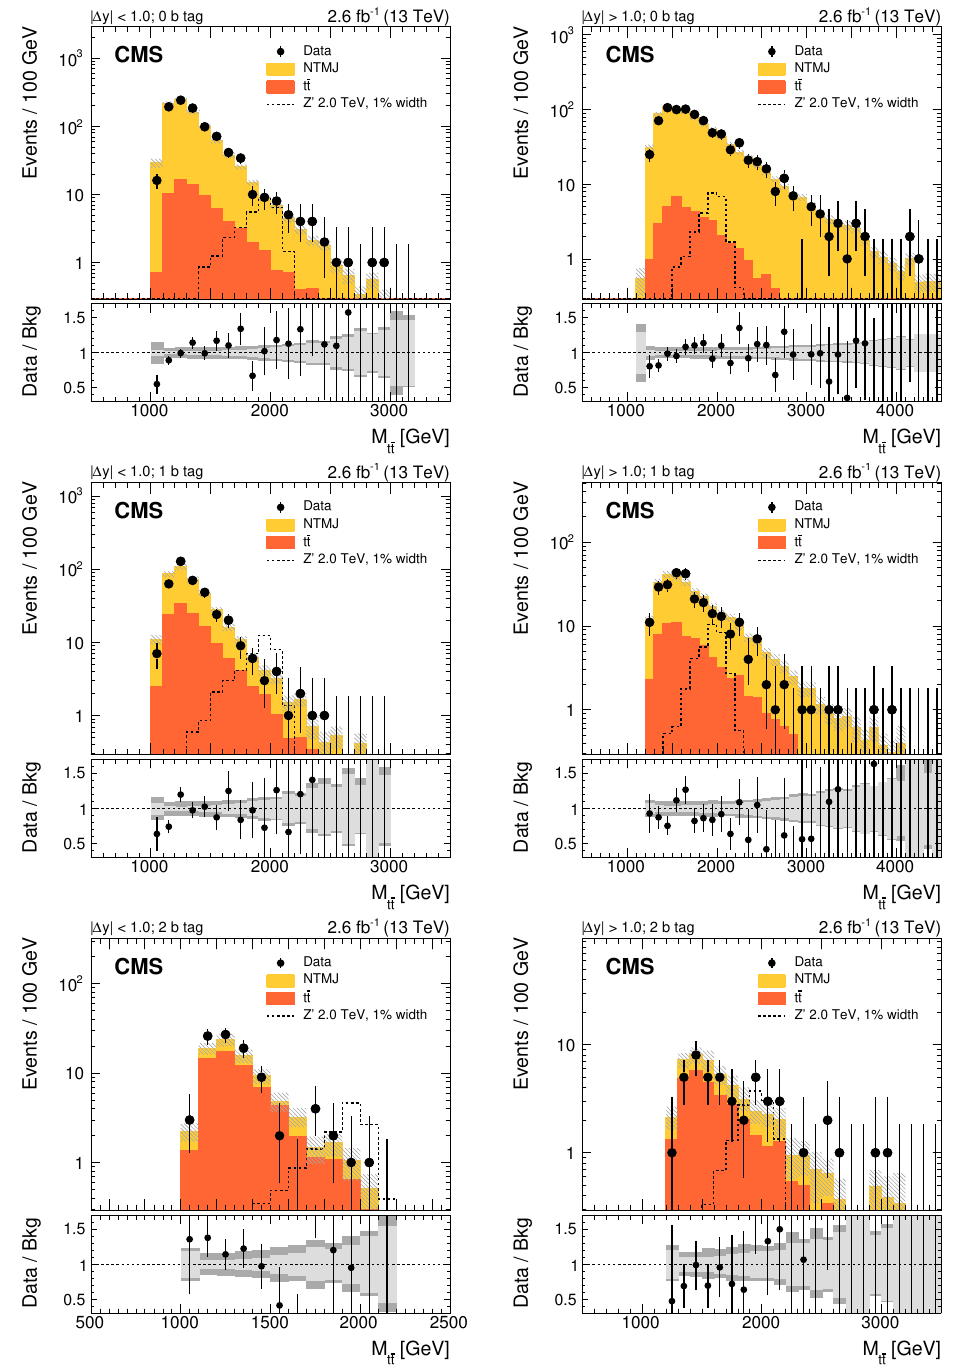
Figure 5 . Distributions in M for data and expected background, for events passing the signal tt selection of the fully hadronic analysis after the maximum likelihood (cid:12)t. Distributions are shown for the regions with j (cid:1) y j < 1 : 0 (left) and j (cid:1) y j > 1 : 0 (right), for 0, 1, or 2 subjet b tags (from upper- most to lowest). The signal templates are normalized to a cross section of 1 pb. The uncertainties associated with the background expectation include the statistical and all post-(cid:12)t systematic un- certainties. The lower panel in each (cid:12)gure shows the ratio of data to predicted SM background, with the statistical (light gray) and total (dark gray) uncertainties shown separately.